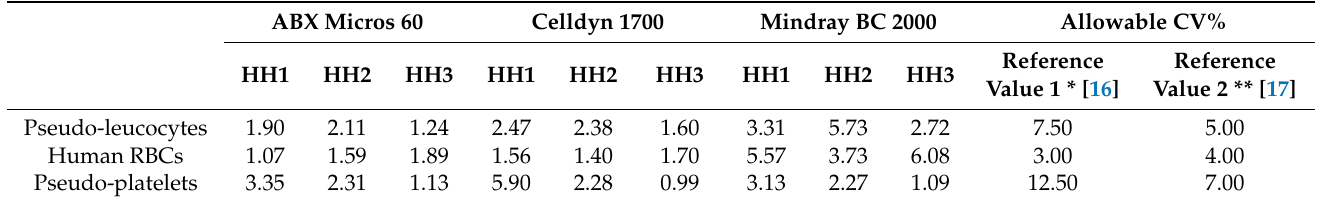
Table 3. CV% results of three concentration levels after analysis on the three hematology analyzers. ABX Micros